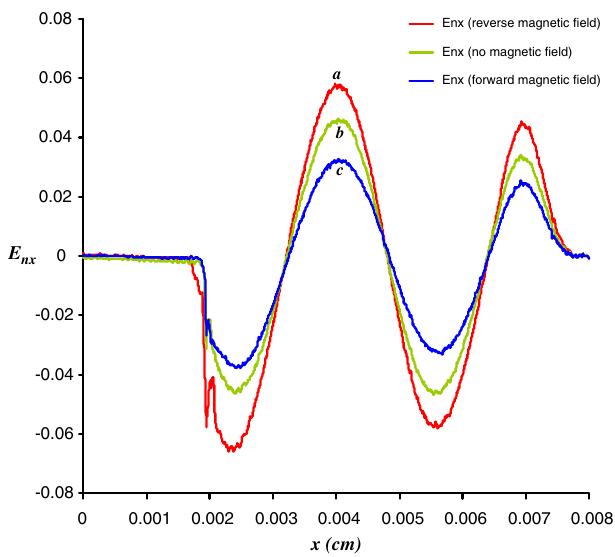
FIG. 6. Variation of normalized longitudinal electrostatic Þ with x for (cid:1) ¼ (cid:4) 1 (curve a ), (cid:1) ¼ 0 (curve b ), wakefield ð E nx and (cid:1) ¼ þ 1 (curve c ) for a 0 ¼ 0 : 3 using 2D XOOPIC simulation